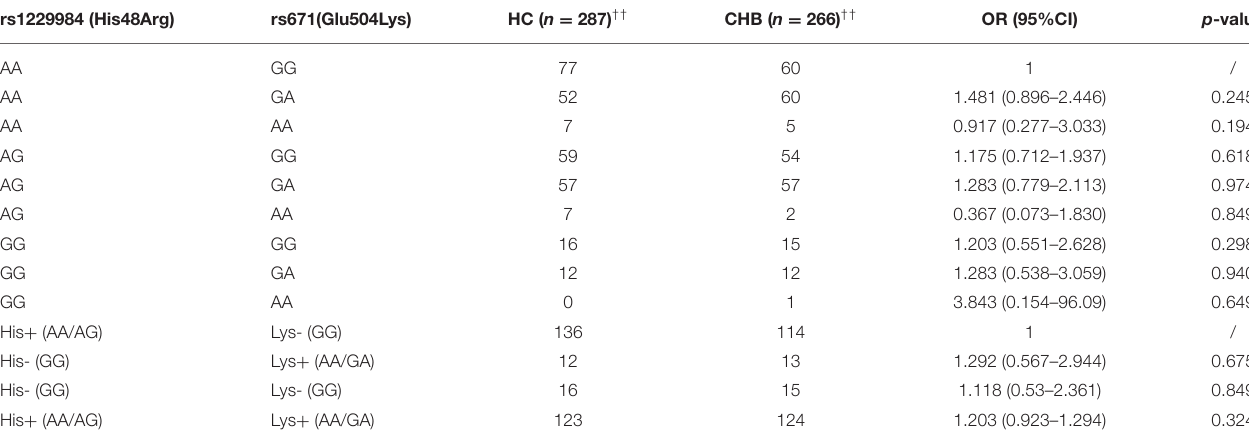
TABLE 4 | CHB risk due to the combination of ADH1B and ALDH2 genotypes. rs1229984 (His48Arg)